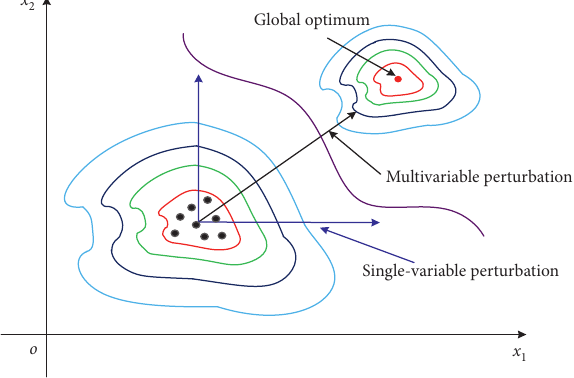
Figure 6: The local optimum situation for a typical multimodal problem